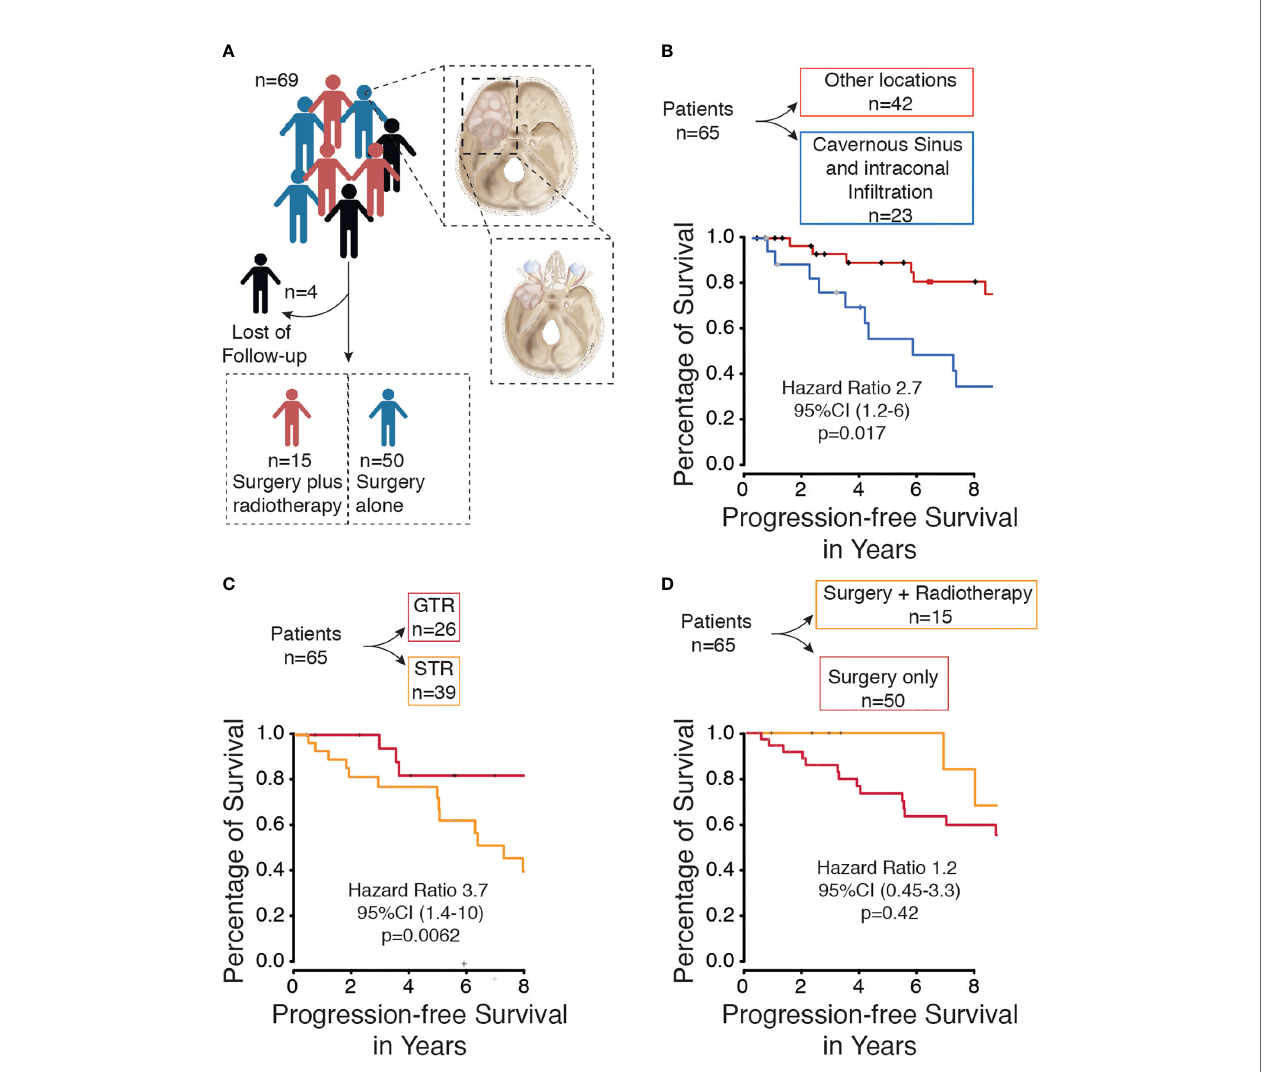
FIGURE 1 | (A) Flow diagram of included patients with spheno-orbital meningioma from our database. (B) Kaplan-Meier curve for progression-free survival based on tumor location. (C) Kaplan-Meier curve for progression-free survival based on extent of resection. (D) Kaplan-Meier curve for progression-free survival based on Therapy (Surgery only vs. surgery plus